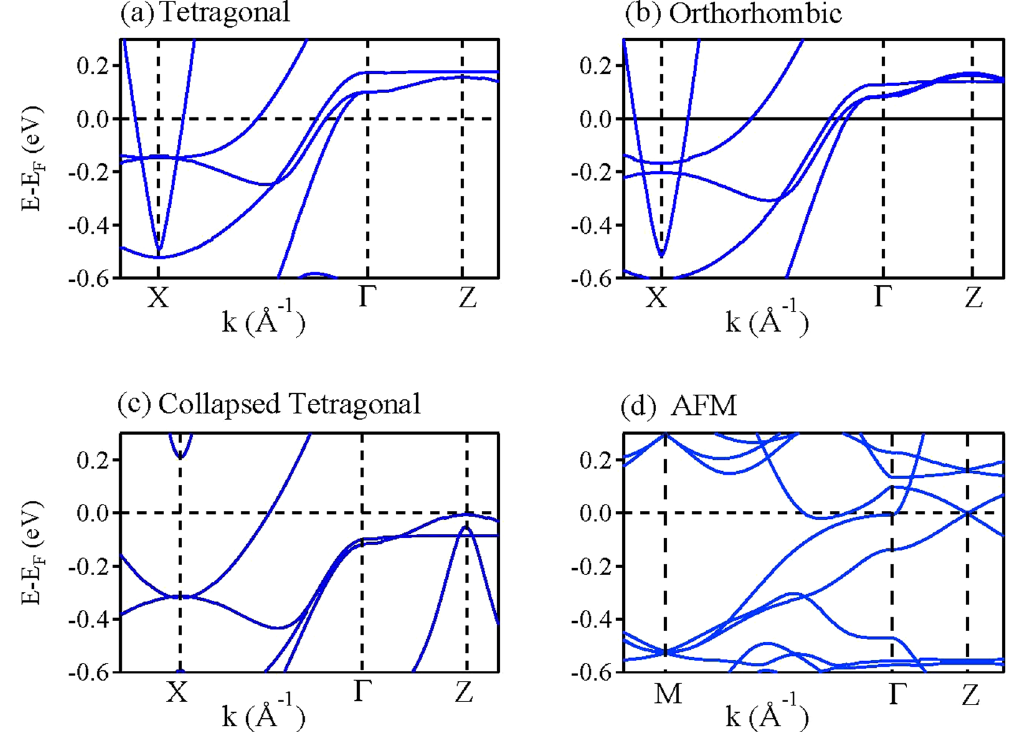
Figure 16. Calculated energy bands of ( a ) tetragonal phase, ( b ) orthorhombic phase, ( c ) non magnetic collapsed tetragonal phase and ( d ) antiferromagnetically ordered orthorhombic phase.